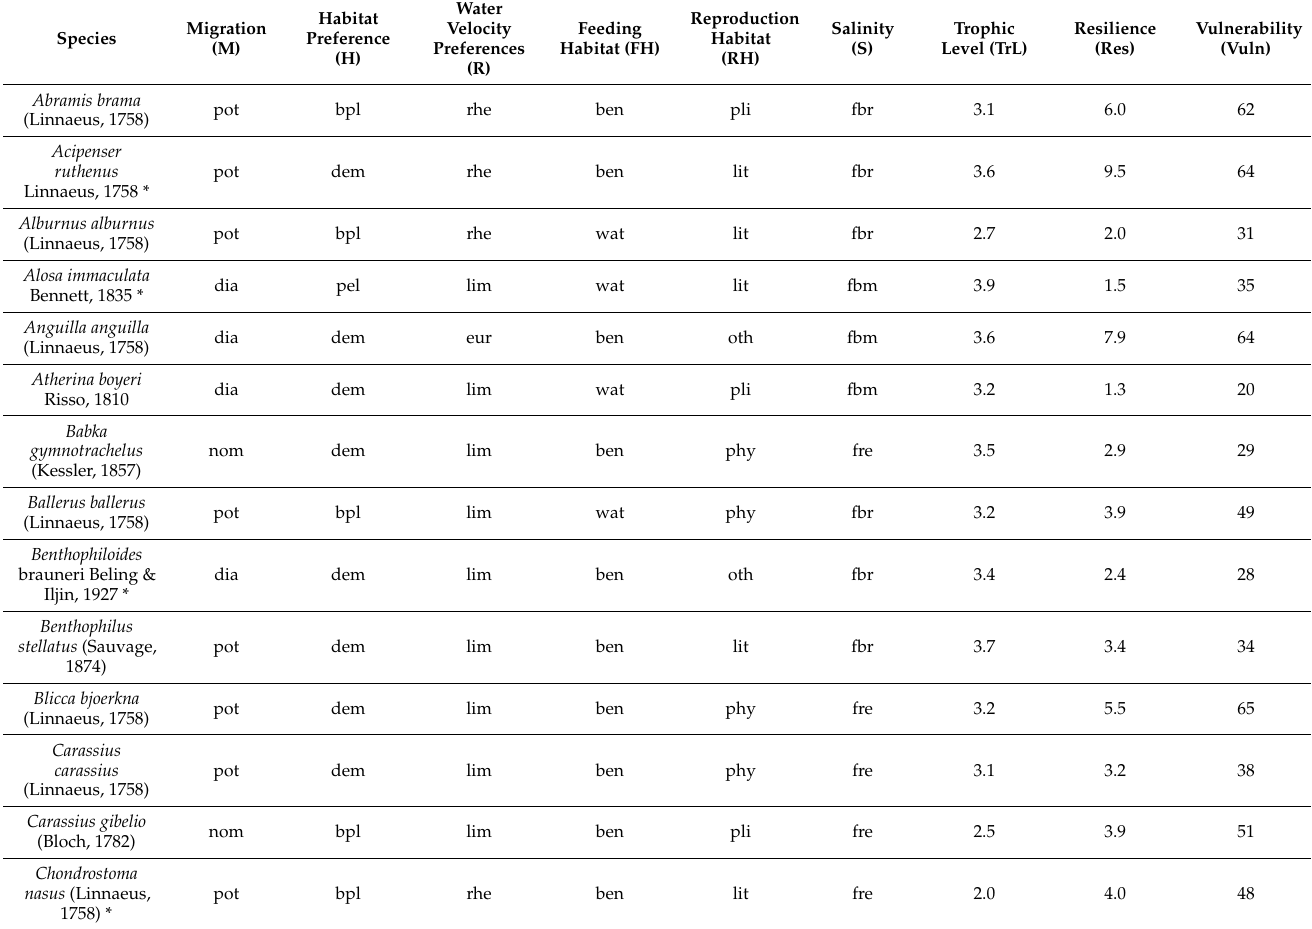
Table A1. Ecological traits of